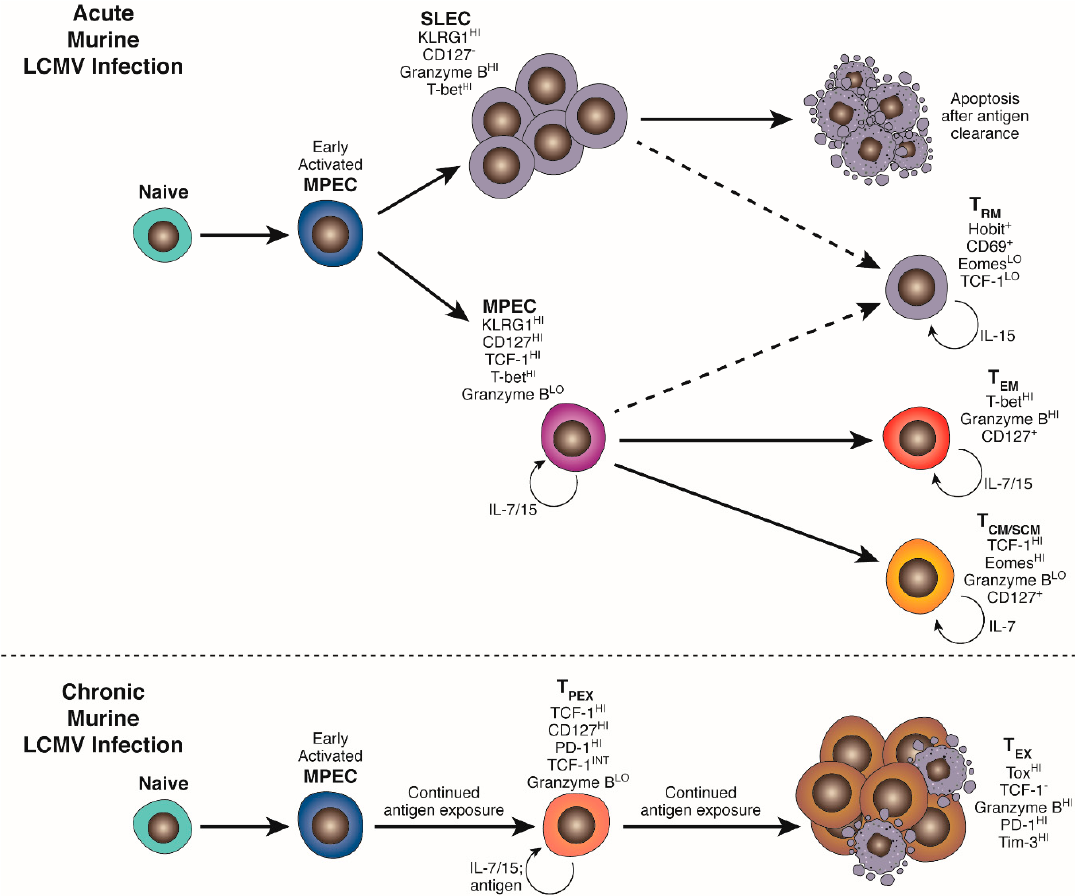
Figure 1. Acute and chronic infection drive distinct programs of CD8 + T cell differentiation. Activated naïve CD8 + cells initiate a program of metabolic, transcriptional and epigenetic changes that facilitate differentiation into KLRG1 HI CD127 neg effector and KLRG1 neg CD127 HI memory precursors (MPEC). In an acute infection, an expanded pool of terminally differentiated cytotoxic effectors (SLEC/T EFF ) clear infected cells and subsequently contract, leaving behind a heterogeneous pool of MPEC-derived self-renewing stem-like (T SCM ) and central memory (T CM ) in secondary lymphoid organs and effector memory (T EM ) and resident memory (T RM ) in peripheral tissues to provide protection against secondary exposure to the same pathogen. Chronic TCR stimulation, exacerbated by the absence of appropriate CD4 + T cell “help” and co-stimulatory and cytokine signalling, drives an alternative program of differentiation and epigenetic remodeling mediated by NFATc1, BATF, IRF4 and Tox. This gives rise to a TCF-1 + PD-1 INT pool of self-renewing “precursor” exhausted cells carrying a distinct epigenetic signature (T PEX ) that produce and continually replenish an expanded pool of terminally exhausted progeny (T EX ) able to partially control, but not fully clear, established infection. T EX maintain the epigenetic signature established in T PEX and exhibit a spectrum of effector function impairment and high expression of a suite of co-inhibitory receptors.